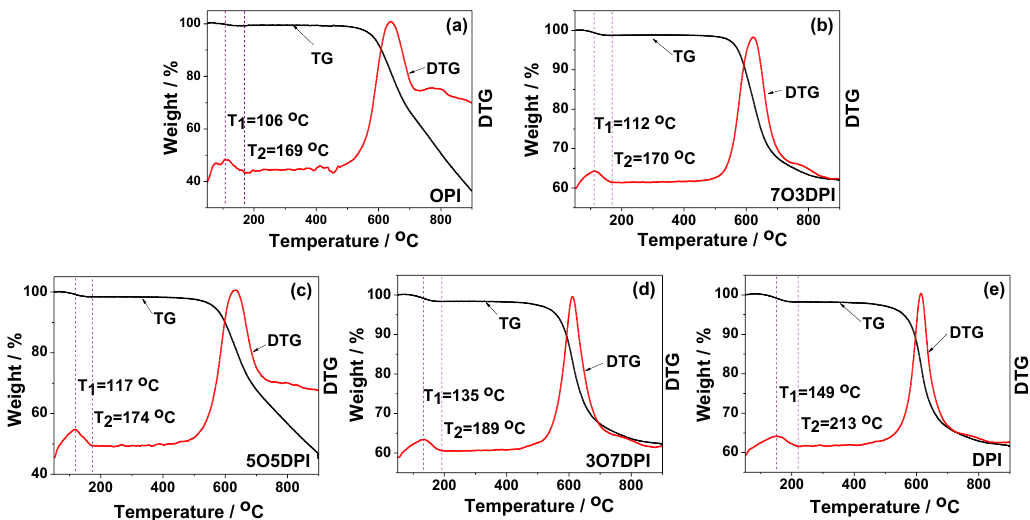
Figure 8. TG and DTG curves of the saturated water-absorbing polyimide films. ( a ) OPI; ( b ) 7O3DPI; ( c ) 5O5DPI; ( d ) 3O7DPI; ( e ) DPI.